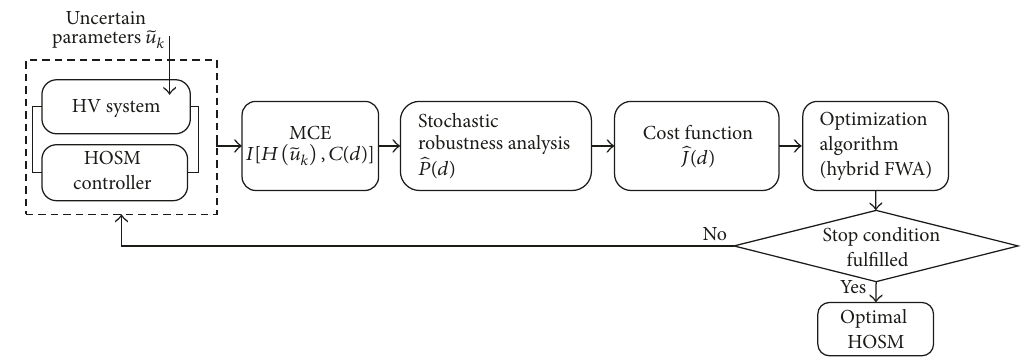
Figure 4: Flowchart of HOSM control design based on